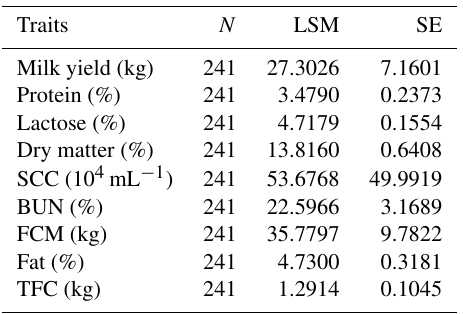
Table 4. The number of records and the means and standard devia- tions for the Chinese Holstein dairy cattle milk traits involved in the association